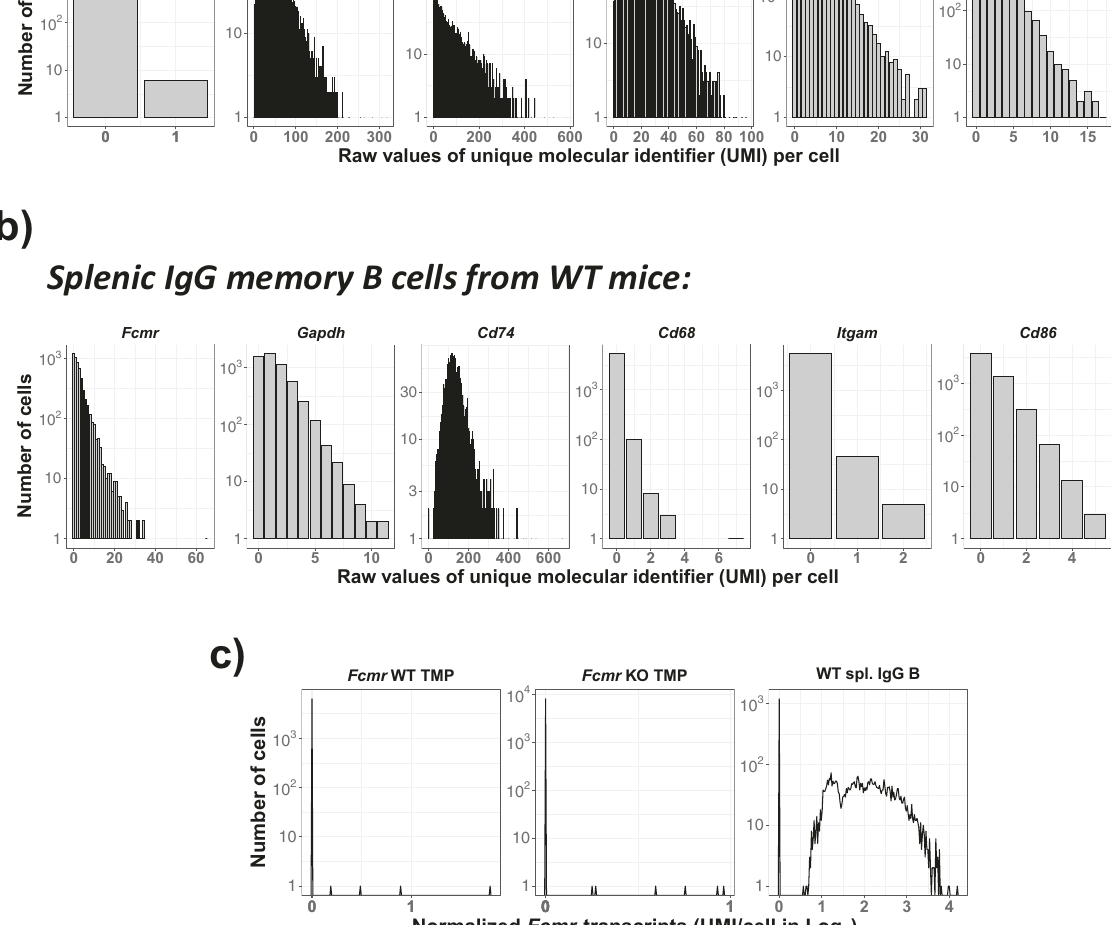
Fig. 1 Gene detection histogram. a , b Raw values for the number of cells and the number of transcript reads (or unique molecular identi fi er; UMI) of the indicated genes in tumor-associated mononuclear phagocytes (TMPs) from C57BL/6 Fcmr WT (upper) and KO (lower) mice ( a ) and IgG memory B cells from C57BL/6 WT spleen ( b ), are plotted on y -axes and x -axes, respectively. c Density curves of normalized UMIs for Fcmr transcripts in TMPs from Fcmr WT and KO mice and from WT splenic IgG B cells. The TMP data 1 were derived from GSE130287 and the IgG B cell data 5 from our scRNAseq analysis GSE140133. Note different scales of the x -axis for each gene.